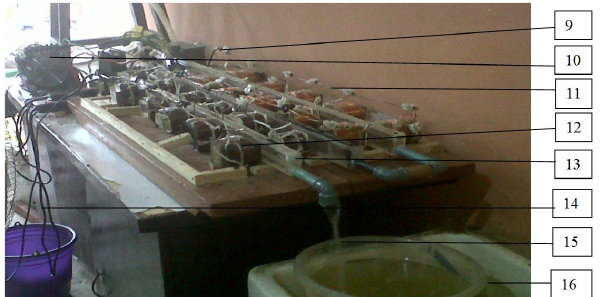
Fig. 1. Electromagnetic treatment system with a fan 1- water tank, 2- tap, 3- hose, 4- stood, 5- variable voltage device, 6- pipe, 7- electromagnet, 8- cooling